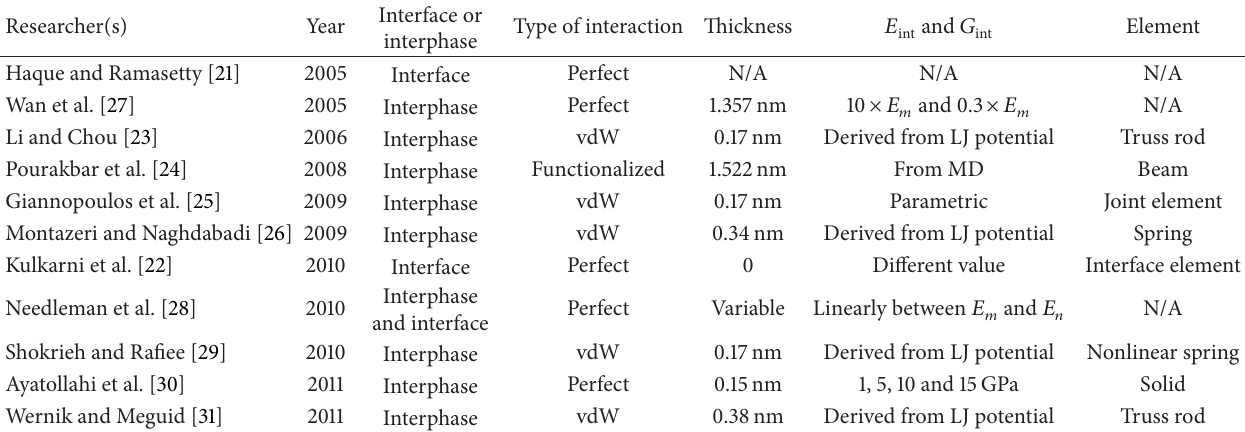
Table 3: Finite element modeling of CNT and polymer